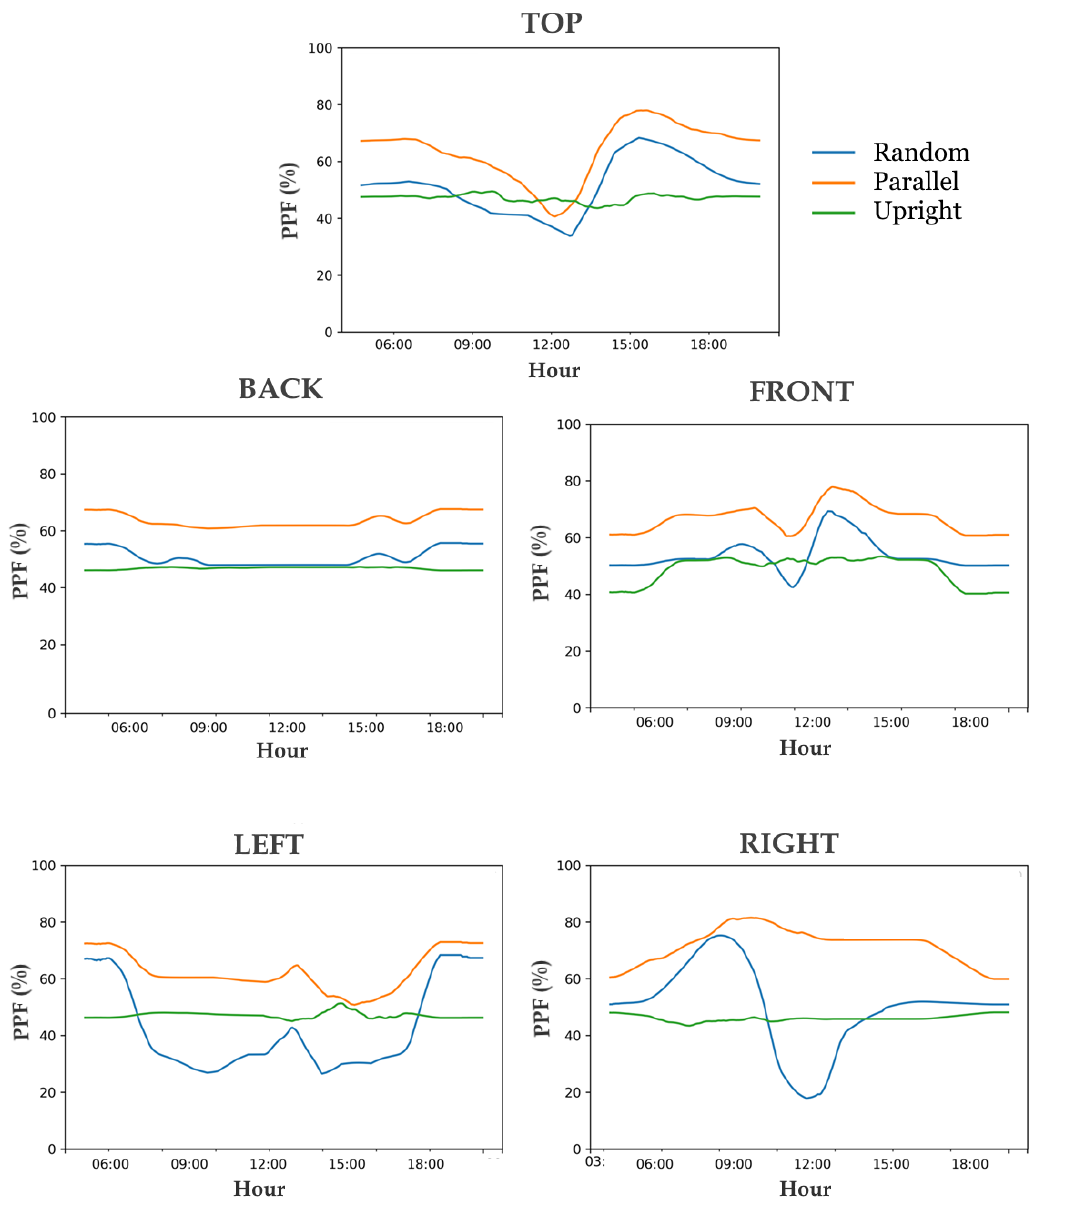
Figure 6. Daily PPFs using a moving average smoothed curve with 1 hour window for all the hair orientations and alignments. The marked hours in the plots (6, 9, 12, 15, 18) correspond to the following SZA: 71.1°, 40.9°, 26°, 47.9°, 78.2°.